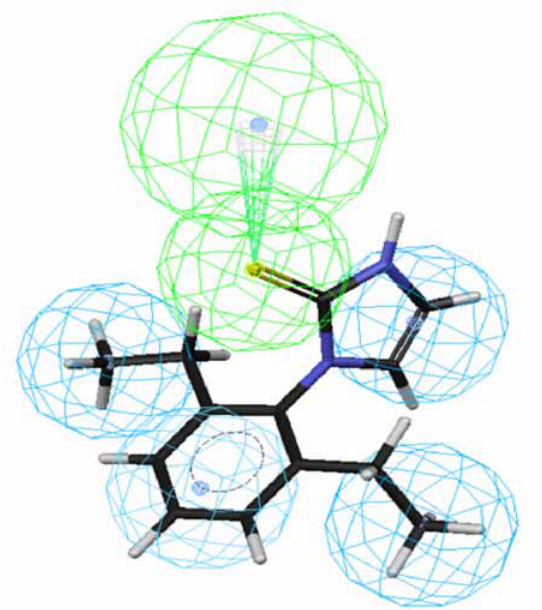
Figure 2. Mapping of 43 to hypothesis 1, which contains an HpAr (blue), three HpAls (blue) and an HBAl